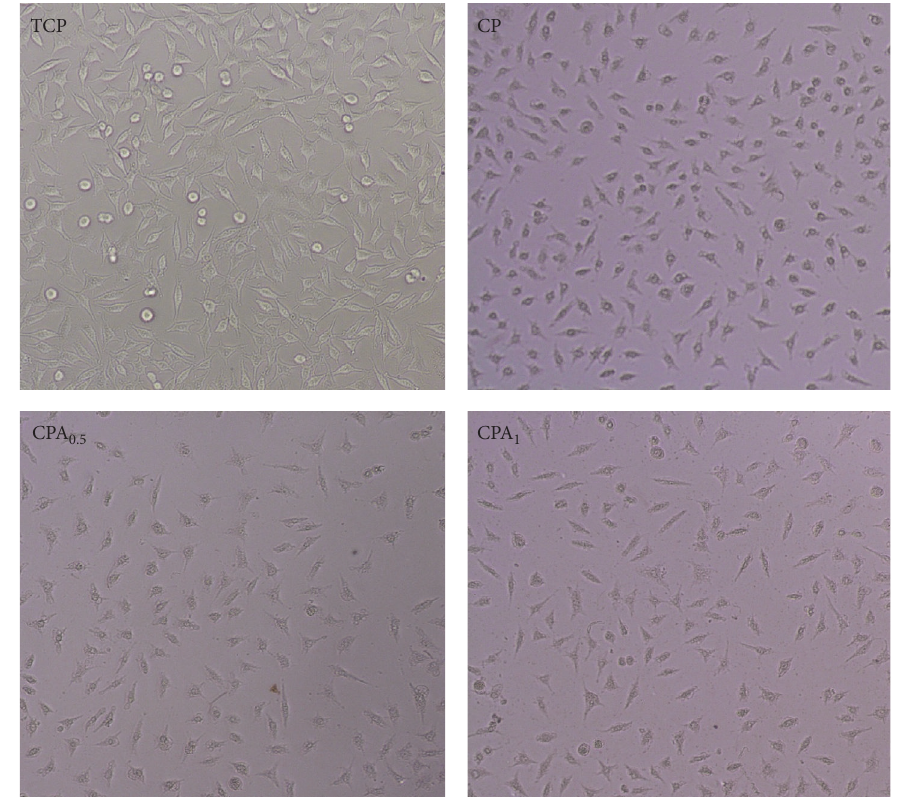
Figure 8: Cell proliferation on control (TCP) and the extracted solution of CP, CPA 0.5 , and CPA 1